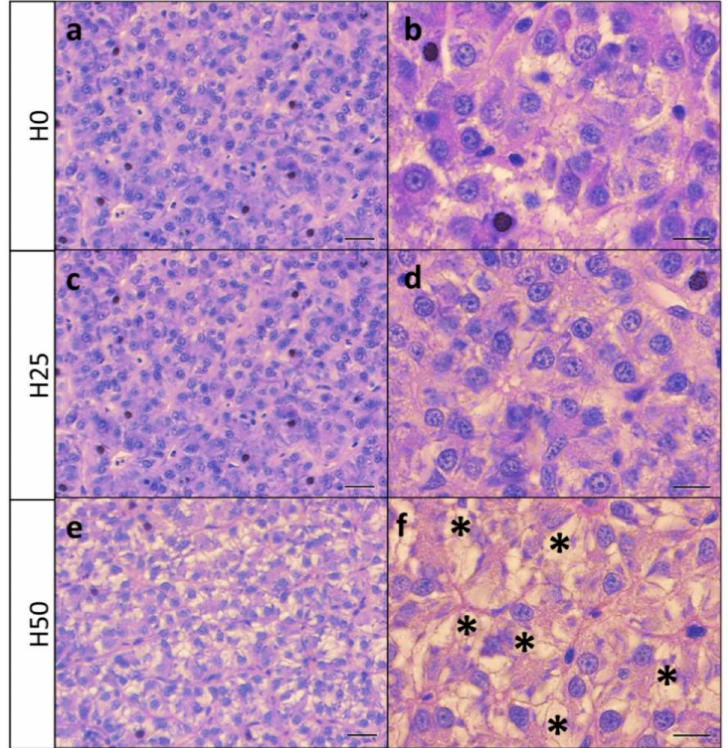
Figure 3. Liver histology of rainbow trout stained with periodic acid of Shi ff (PAS). Low and high magnification of sections of liver from group H0 ( a , b ), H25 ( c , d ) and H50 ( e , f ). (Asterisks indicate lipid accumulation. Scale bars: ( a , c , e ) = 20 µ m; ( b , d , f ) = 10 µ